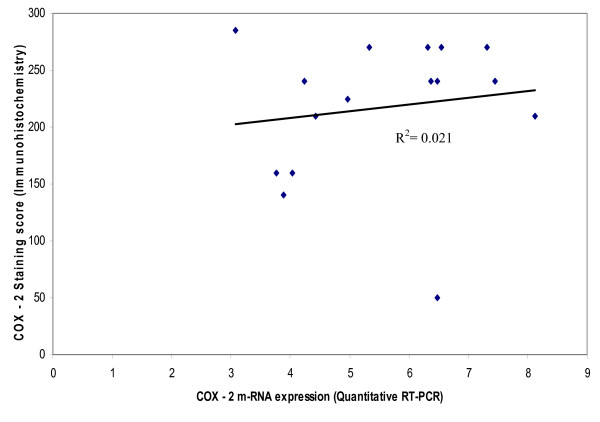
Correlation between COX-2 m-RNA and COX-2 protein expression in biopsies from oesophageal adenocarcinoma.